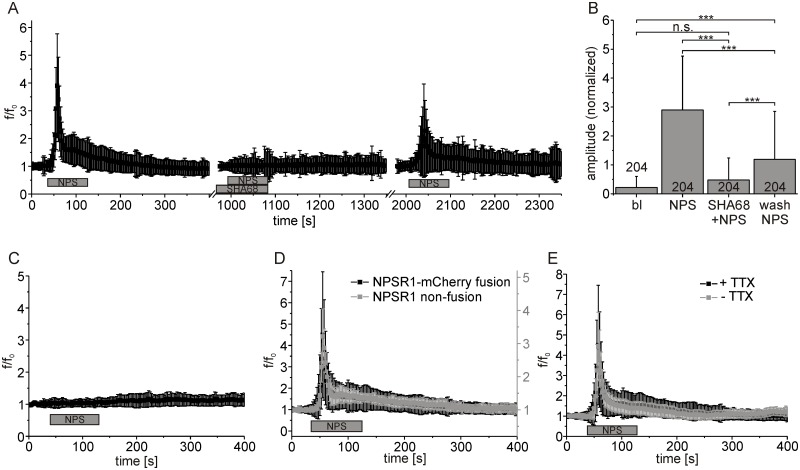
NPS-dependent calcium signals are abolished by the NPSR1 antagonist SHA68.(A) Mean fluorescence values recorded from 397 hippocampus neurons. NPS [250 nM] and the NPSR1 blocker SHA68 [1 μM] were applied as indicated. (B) Statistical comparison of mean fluorescence amplitudes from experiments shown in (A). SHA68 reduced the effect of NPS to a level non-significantly different from baseline (bl). (C-E) Control experiments. (C) In 936 untransfected hippocampus neurons, no increase in normalized mean fluorescence intensity could be detected when NPS was applied. (D) Normalized mean fluorescence values from 229 neurons expressing NPSR1 as a mCherry fusion protein from AAV-NPSR1-TS-mCherry-ER (black) and from 5 neurons expressing NPSR1 as non-fusion protein from NPSR1-IRES-tdTomato (grey). Please refer to the y-scale at the right-hand side (grey) for results from experiments with the non-fusion NPSR1. (E) Normalized mean fluorescence values from neurons expressing NPSR1 recorded in presence (n = 229, black, see Fig. 2B) or absence (n = 122, grey) of 125 nM TTX. NPS was used at 500 nM in the experiments,. if not indicated otherwise.